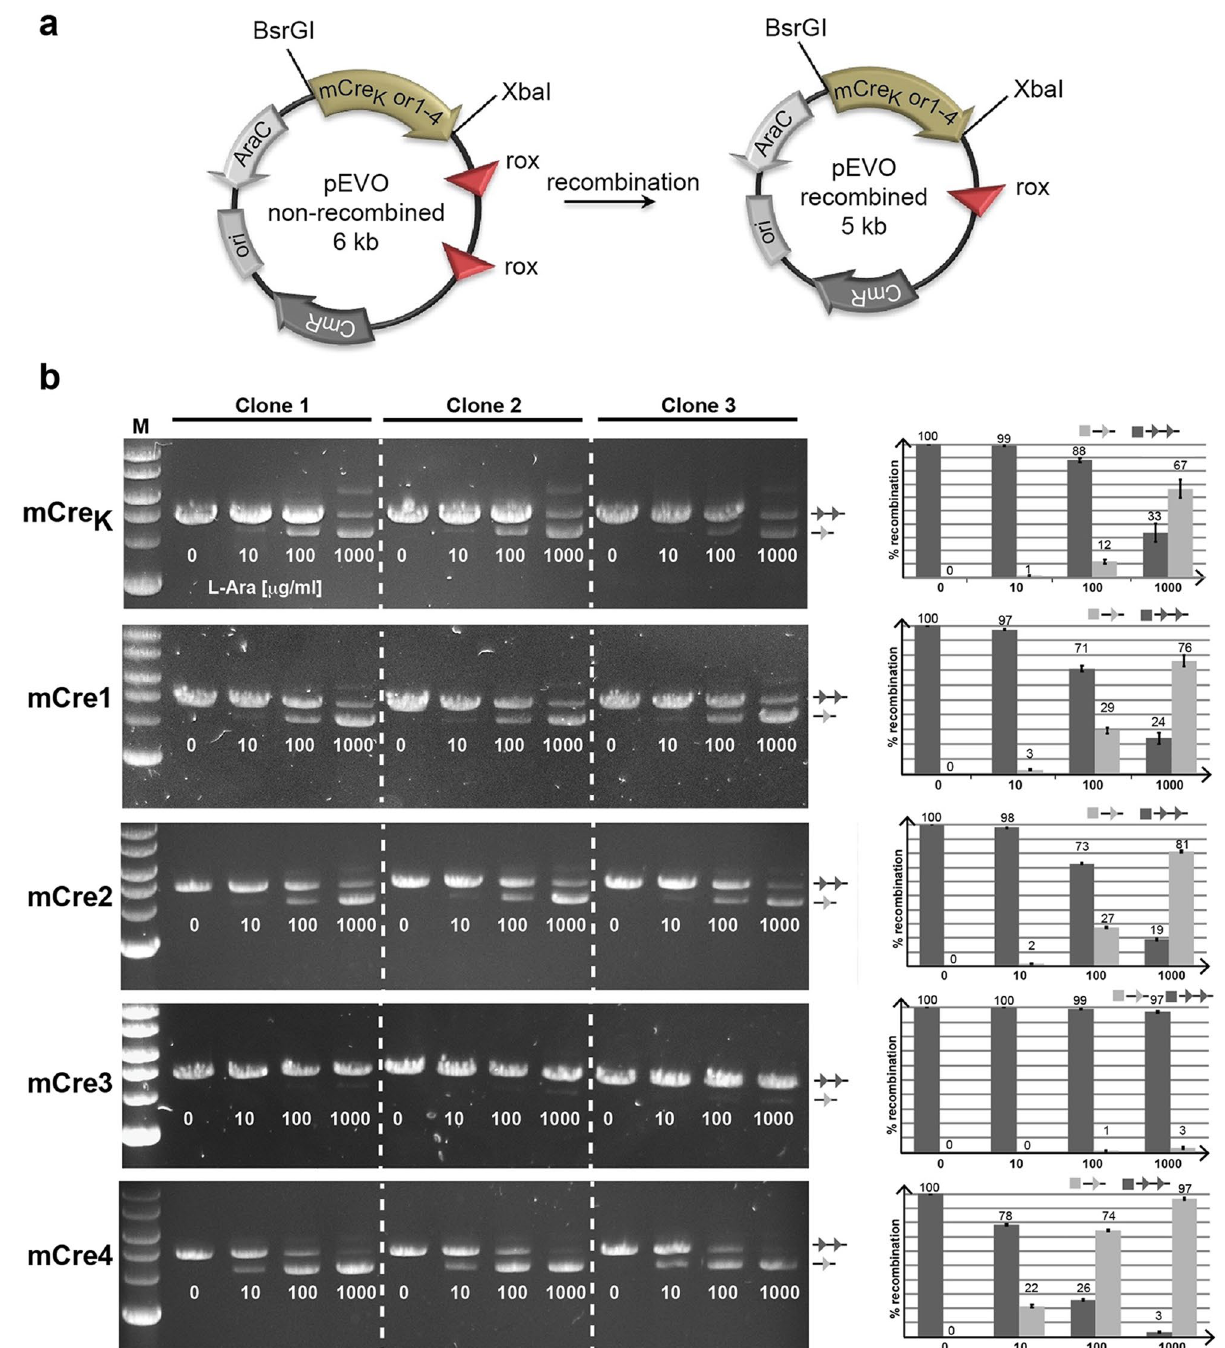
Figure 7. Rationally designed Cre mutants show increased recombination activity in E.coli . ( a ) Schematic drawing of the plasmid assay. Important regions in the plasmids are indicated. Note the reduced size of the plasmid after recombination. The restrictions sites (BsrGI and XbaI) used for cloning indicated Cre- recombinase variants are depicted. The rox target sites are shown as red triangles. CmR, chloramphenicol resistance gene; ori, origin of replication; AraC, arabinose operon regulatory gene. ( b ) Agarose gels of three independently picked clones showing BsrGI and XbaI digested plasmids carrying indicated recombinases. The amount of arabinose added to the growth medium is presented below each band in μg/ml l+-arabinose. The line with two triangles indicates no recombination, whereas the line with one triangle marks the recombined band. Quantifications of the ratios of band intensities (in percent of recombination) are shown to the right for each mutant. The amount of arabinose added to the growth medium is shown on the X-axis. Error bars depict standard deviation from the three independent